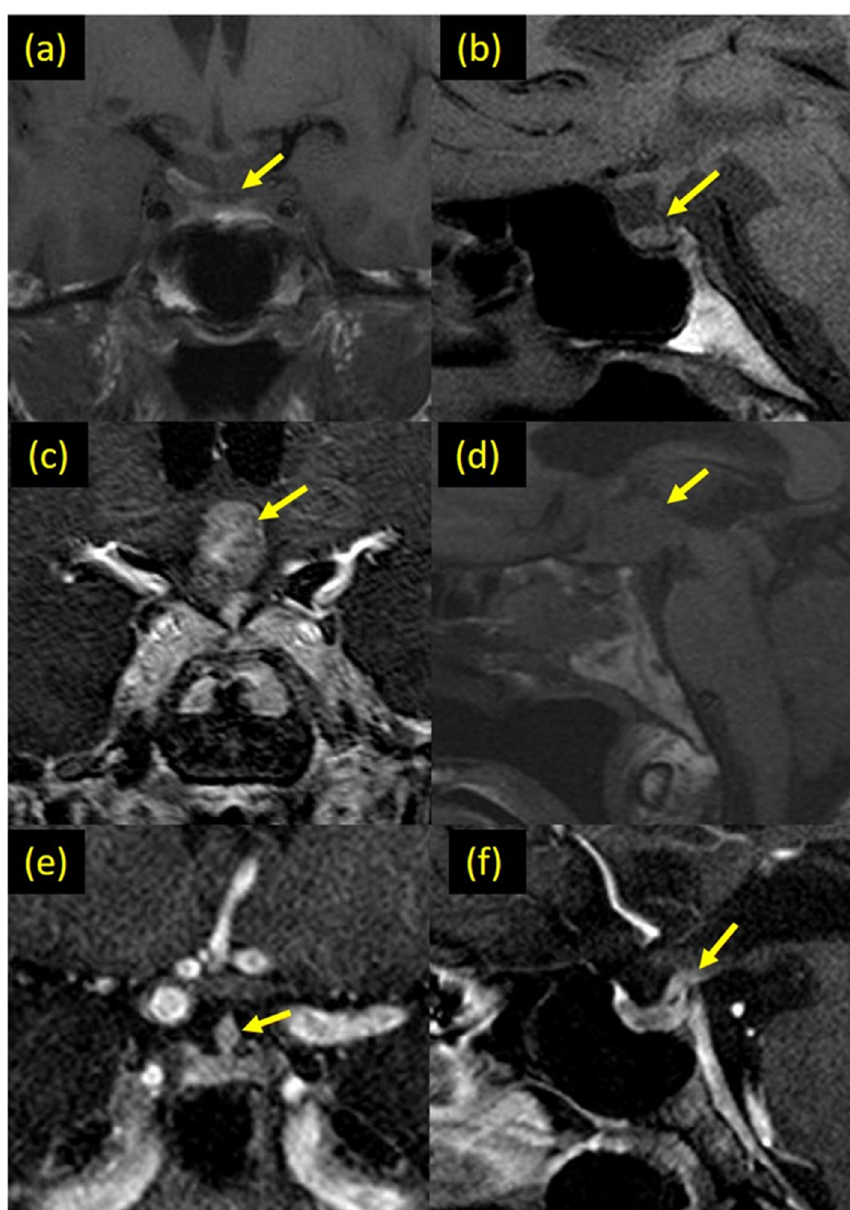
Figure 1. ( a , b ) T1 weighted MRI images of the skull base showing a small size pituitary gland with significant narrowing of the pituitary stalk. ( c ) Coronal T1-weighted post-contrast and ( d ) sagittal T1-weighted pre-contrast MR-images showing suprasellar post-chiasmatic mass involving the pituitary stalk and the hypothalamic floor, which is intensely enhanced in the post-contrast images. ( e ) Coronal T1-weighted post-contrast MR-image showing focal engorgement of the middle segment of the pituitary stalk due to ECD infiltration (early ECD involvement of the pituitary stalk. ( f ) Sagittal T1-weighted post-contrast MR-image showing abnormal thickening of the most proximal end of the pituitary stalk, at the point of its insertion into the hypothalamic floor.